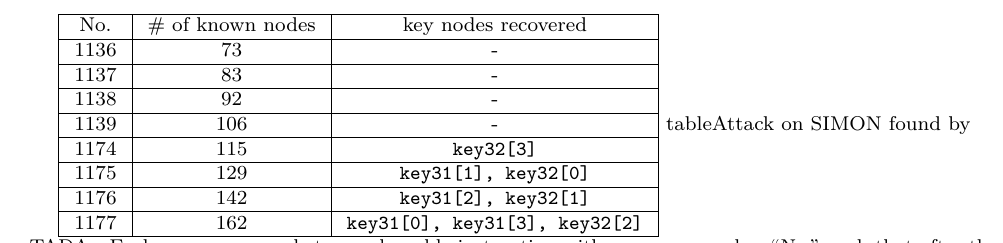
TADA - Each row corresponds to a vulnerable instruction with sequence number “No.” such that after the attack on this instruction, the number of known nodes is given by “# of known nodes” and the key nodes that are retrieved are given by the third column.